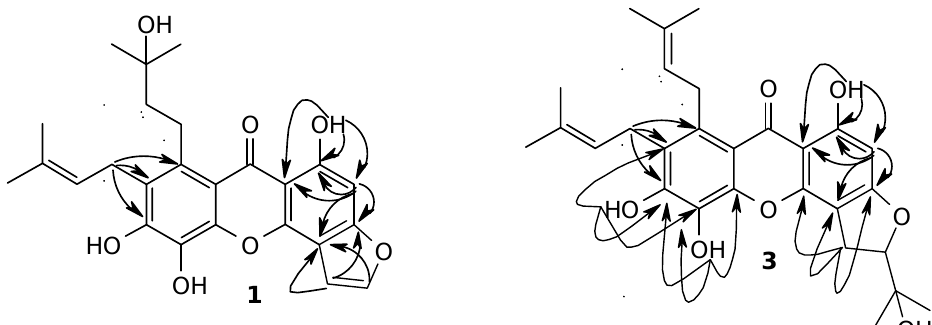
Figure 2. Significant HMBC correlations of compound 1 and 3